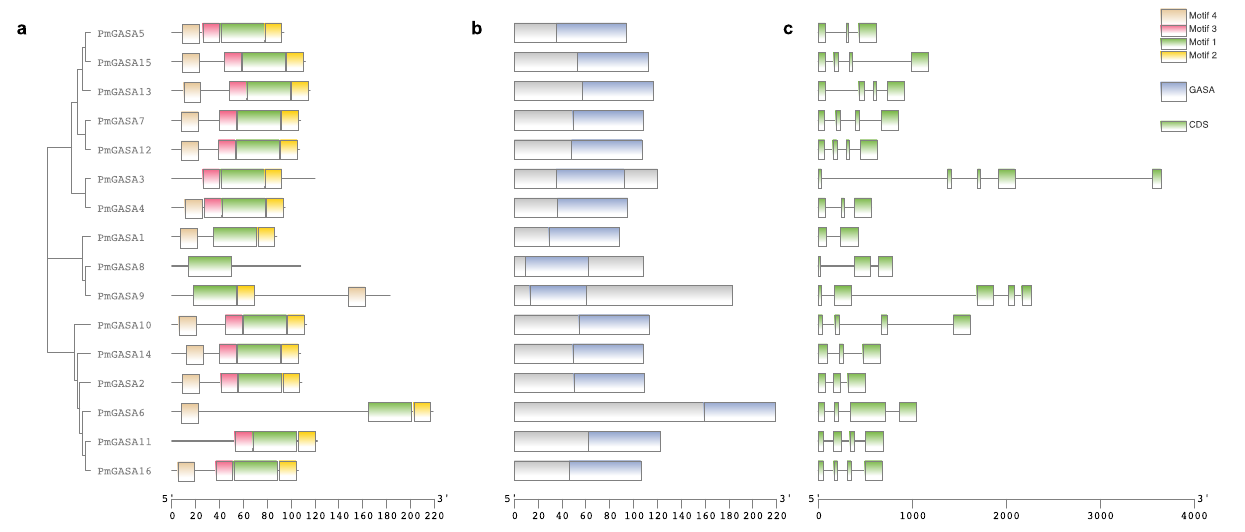
Figure 1. Protein motif and gene structure analysis of GASA family genes identified in P. mume . ( a ) Phylogenetic tree of PmGASA protein sequences with conserved protein motifs colored differently. ( b ) Conserved protein domain identified for PmGASA proteins using the NCBI CDD tool. The blue box indicates the conserved GASA domain identified. ( c ) Exon – intron distribution analysis of PmGASA genes. The green boxes represent exons and the black lines represent intron positions, respectively.